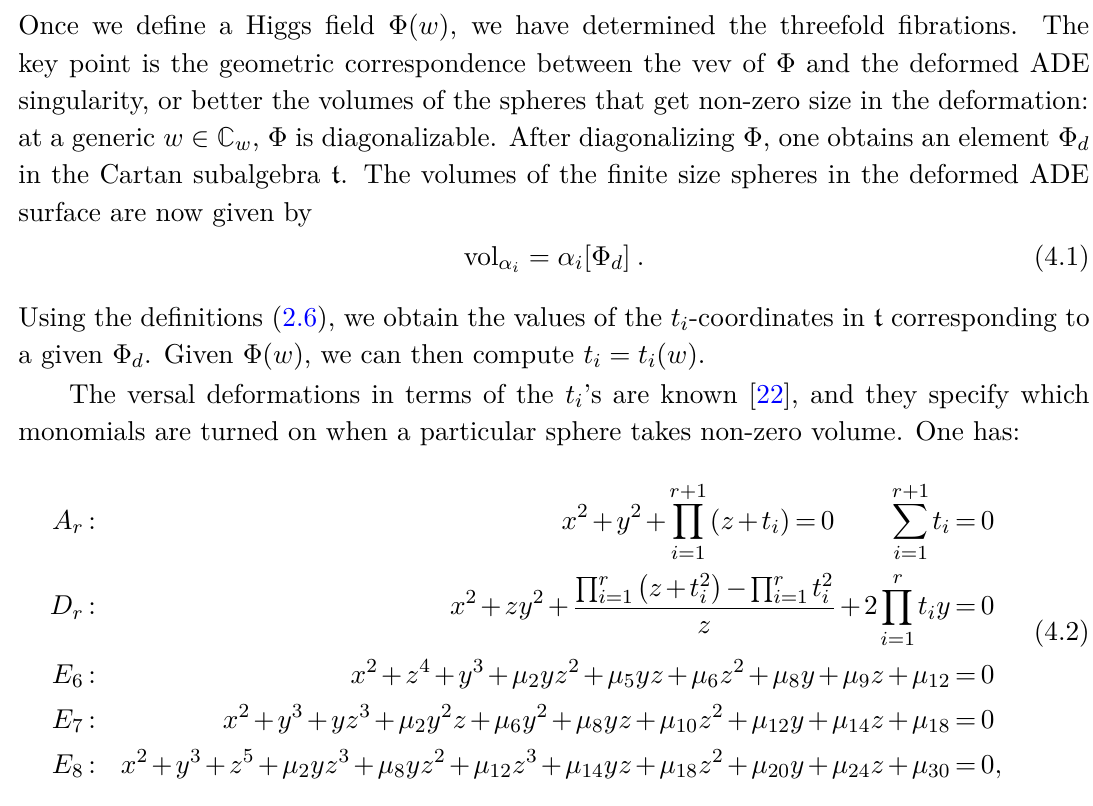
⊕ A 2 subalgebra of D 7 1